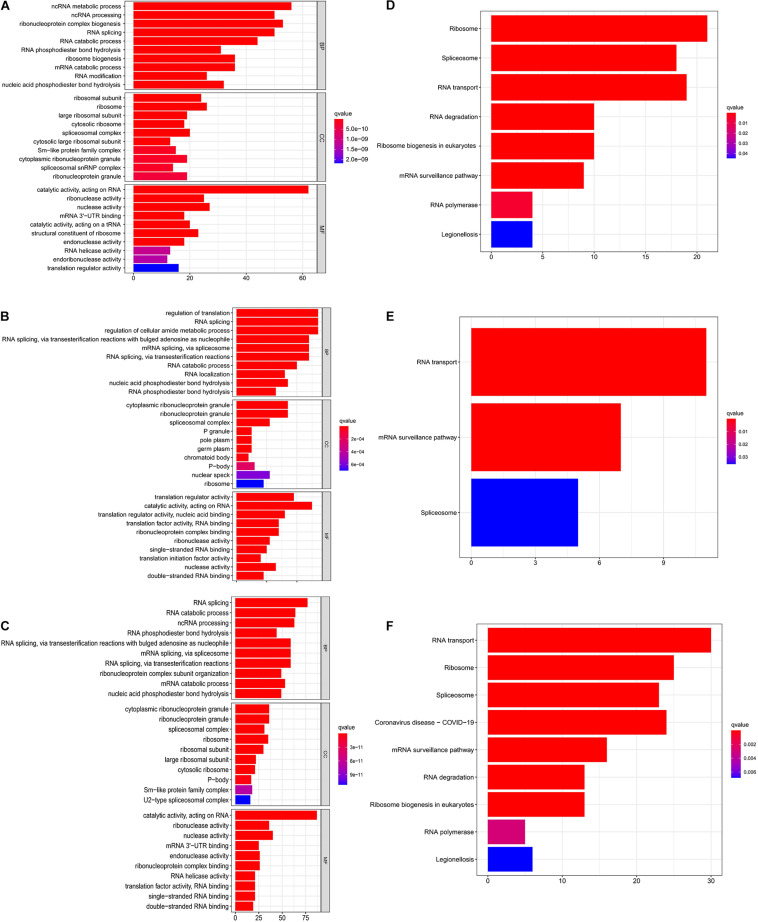
Functional enrichment analyses of 251 upregulated and 129 downregulated RBPs. (A) GO analysis on upregulated RBPs. (B) GO analysis on downregulated RBPs. (C) GO analysis on all the DERBPs. (D) KEGG analysis on upregulated RBPs. (E) KEGG analysis on downregulated RBPs. (F) KEGG analysis on all the DERBPs.